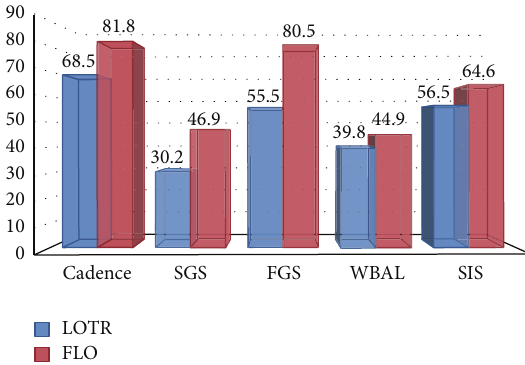
Figure1:Posttestintragroupcomparisonofoutcomevariables.SGS: Slow Gait Speed, FGS: Fast Gait Speed, WBAL: weight bearing on affected limb, and SIS: stroke impact scale